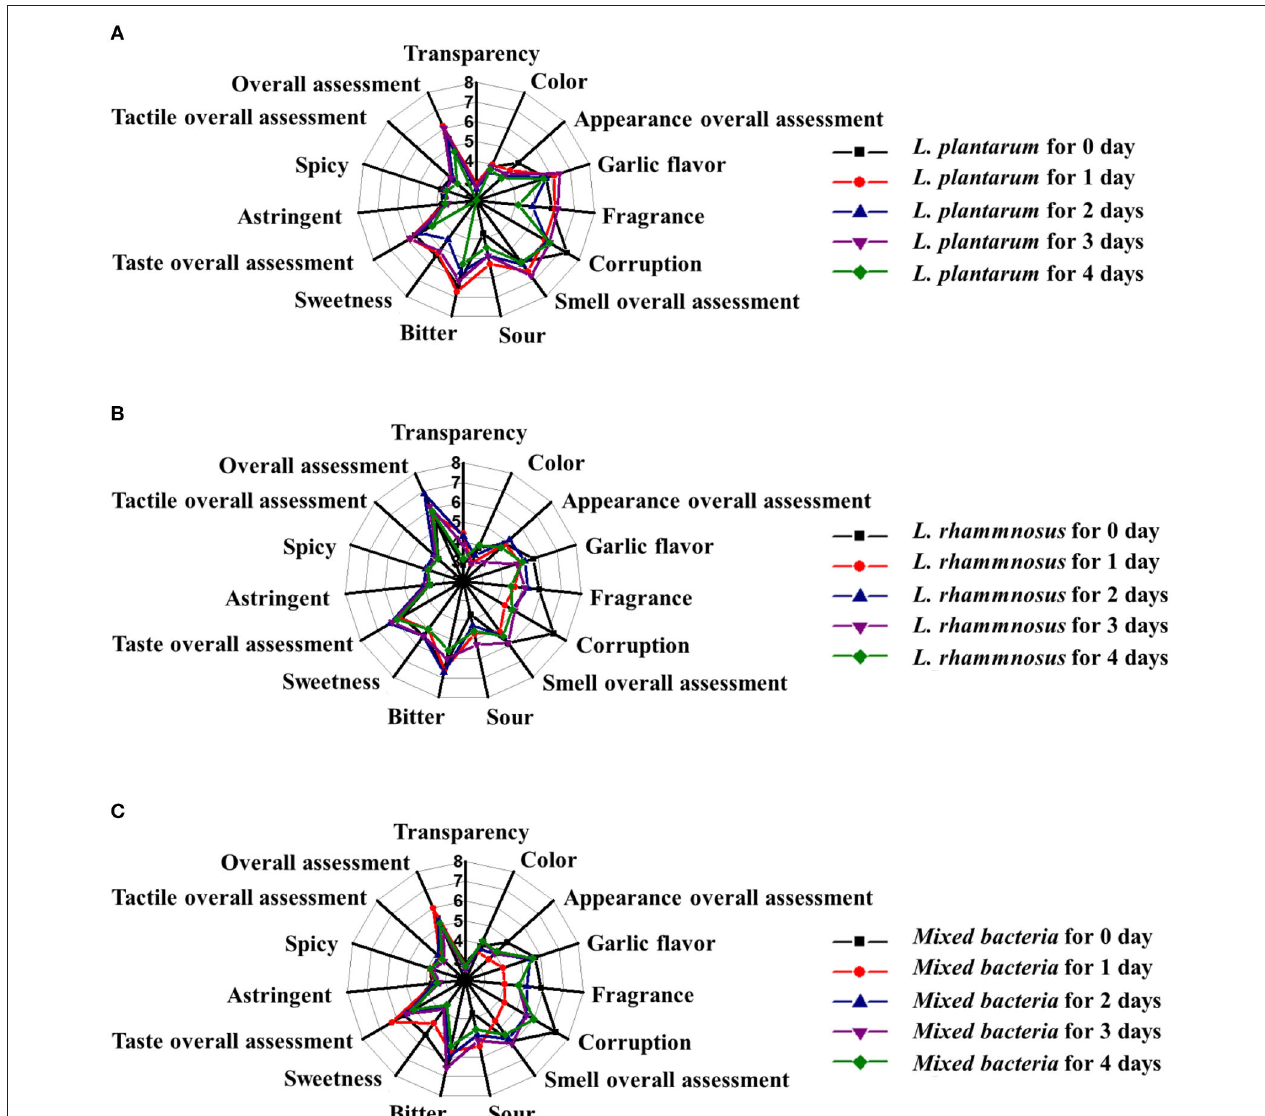
FIGURE 4 | Artificial sensory evaluation of black garlic broths fermented by (A) L. plantarum , (B) L. rhamnosus , and (C) a mixture of the two bacteria at different times (0, 1, 2, 3, and 4 days). Data are means ± SD ( n = 15).